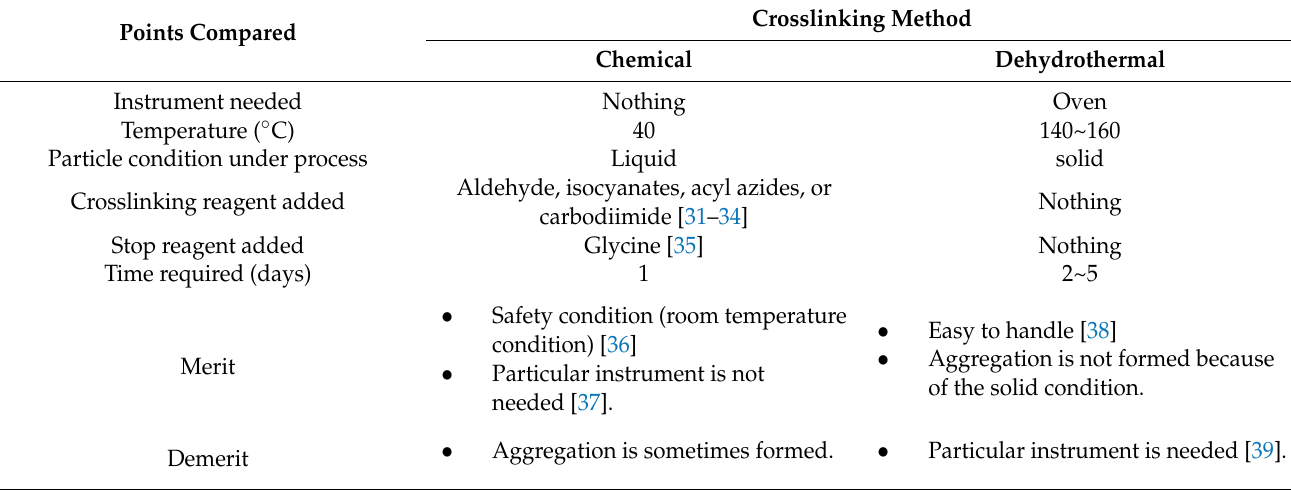
Table 1. Comparison of features between chemical and dehydrothermal crosslinking